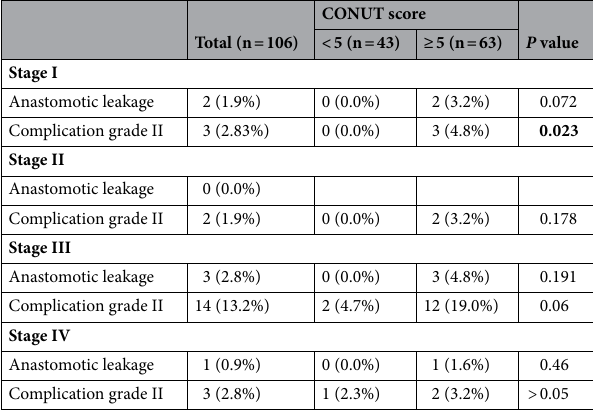
Table 3. The relationship between complications and CONUT score in the hierarchical analysis of tumor stage.